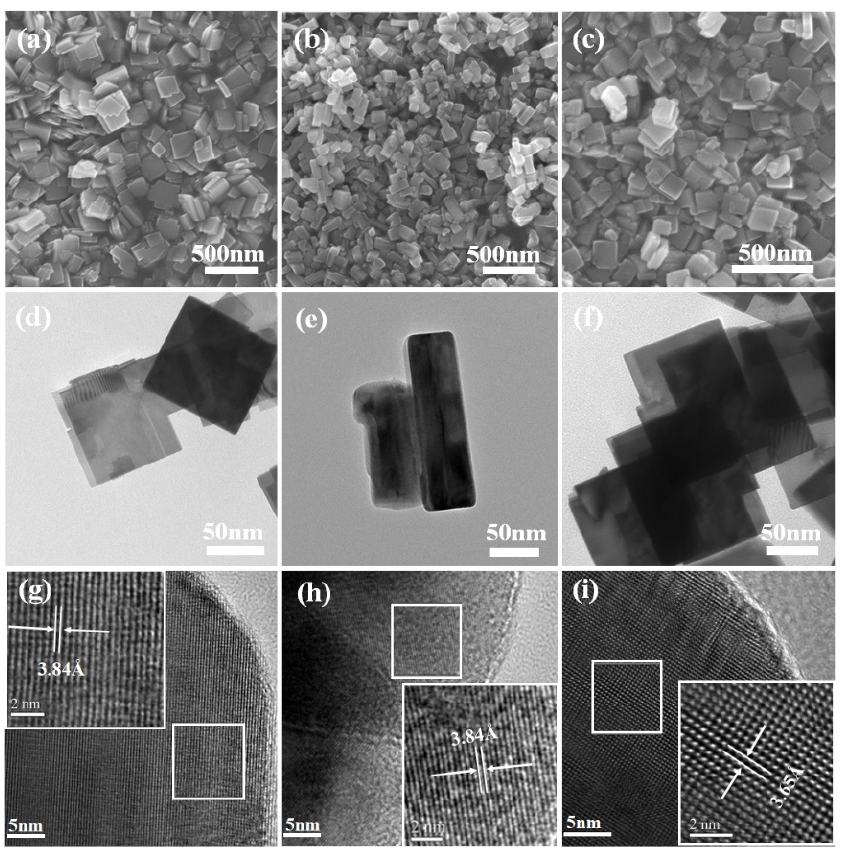
Figure 2. SEM, TEM and HRTEM images of ( a , d , g ) WO 3 -OA, ( b , e , h ) WO 3 -TA and ( c , f , i ) WO 3 -CA.